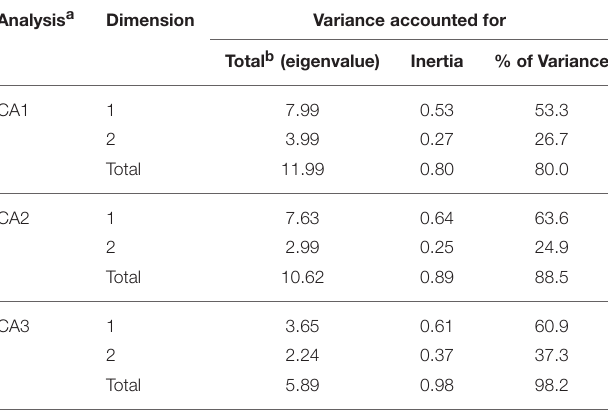
TABLE 5 | Statistics of three correspondence analyses (CA1, CA2, and CA3) performed for seven Venturia species with the data in Table 4 . Analysis a